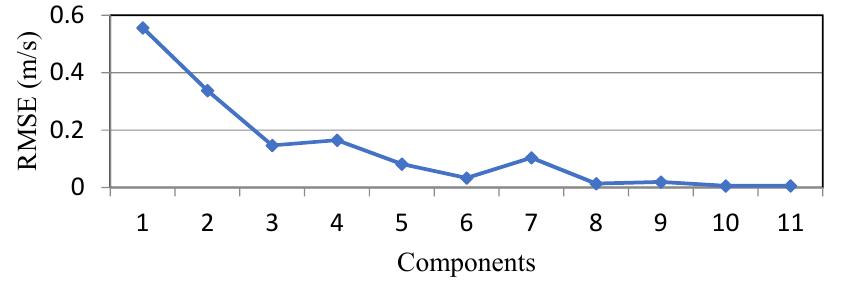
Figure 10. Wind speed prediction directly using DKF.